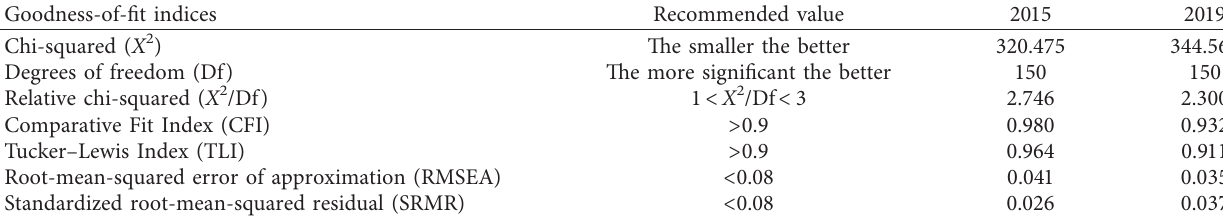
Table 4: Goodness-of-fit indices of the MIMIC model (2015 and 2019 data).